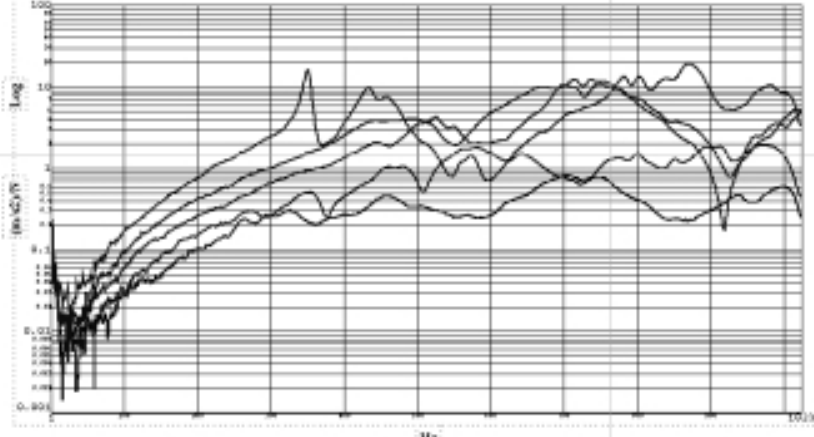
Fig. 6. Examples of FRF’s of the vehicle body at the attachment points of